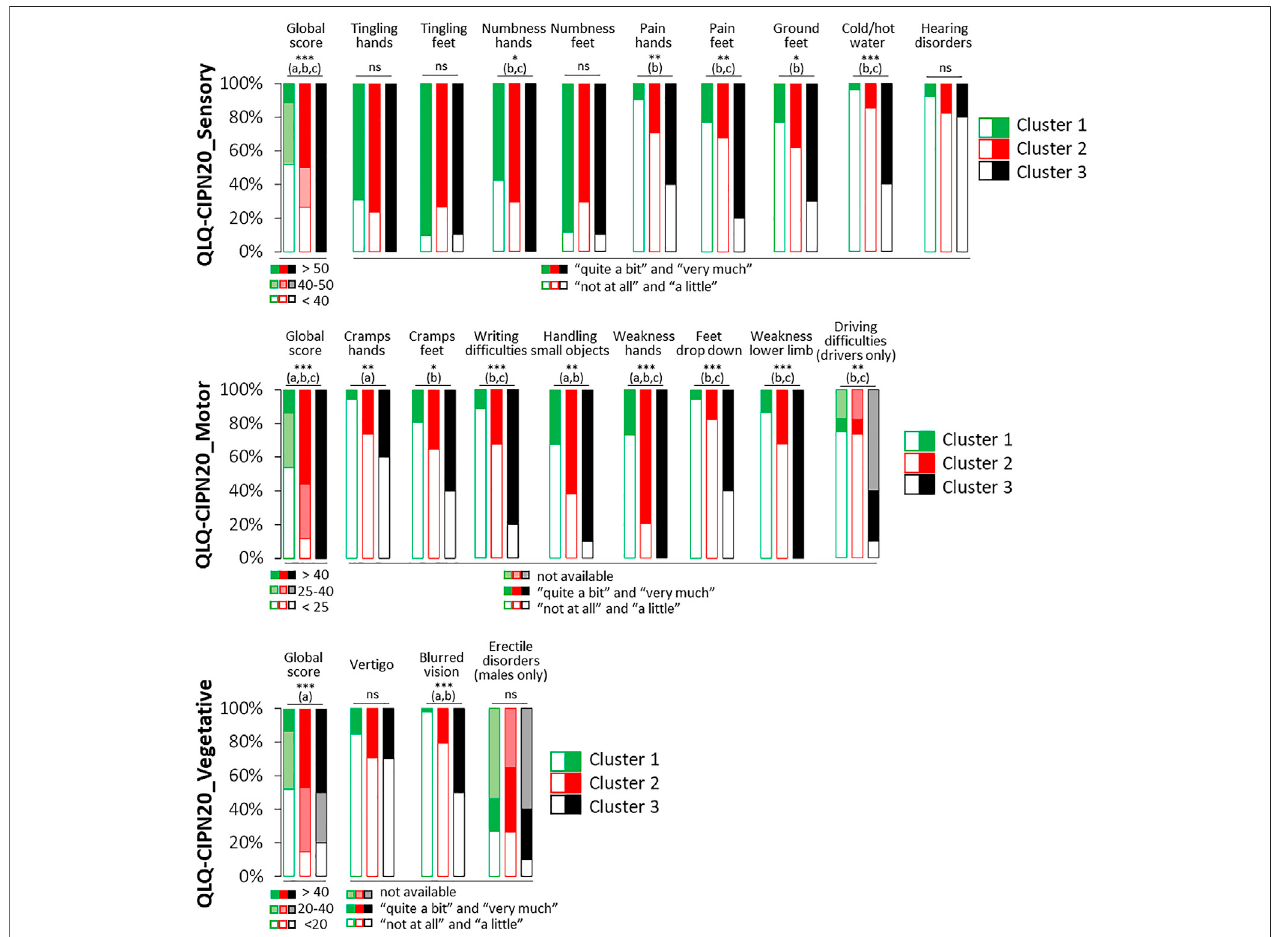
FIGURE 2 | Scores of the QLQ-CIPN20 (sensory, motor and vegetative) among the three clusters of patients with a sensory CIPN. Omnibus p -value: * p < 0.05; ** p < 0.01; *** p < 0.001; ns, not signi fi cant. Signi fi cant difference ( p < 0.05, post hoc analysis) between: a, cluster 1 and cluster 2; b, cluster 1 and cluster 3; c: cluster 2 and cluster